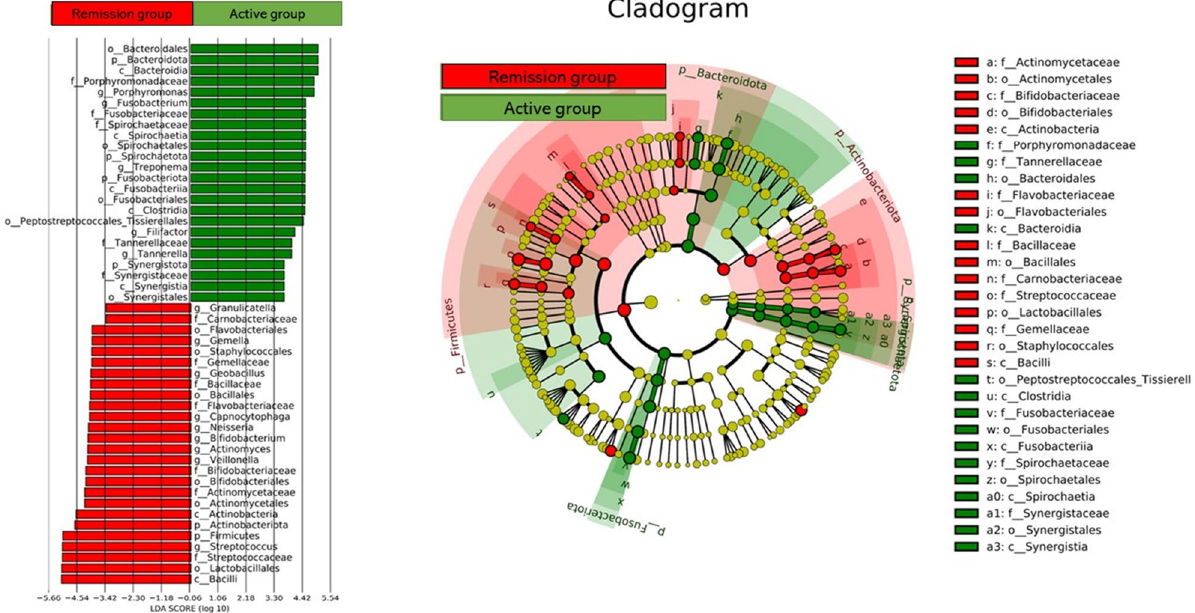
Figure 5. g_ Porphyomonas , g_ Fusobacterium , g_ Treponema , and g_ Tannerella are more abundant in the active group, whereas o_ Lactobacillales and g_ Bifidobacterium are more abundant in the remission